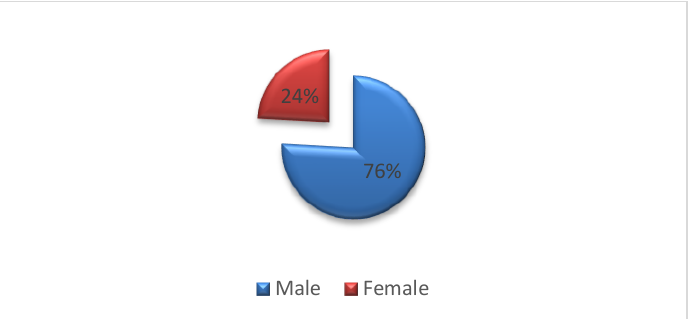
Figure 4: The Distribution of Respondent Profiles: Gender ; Source: